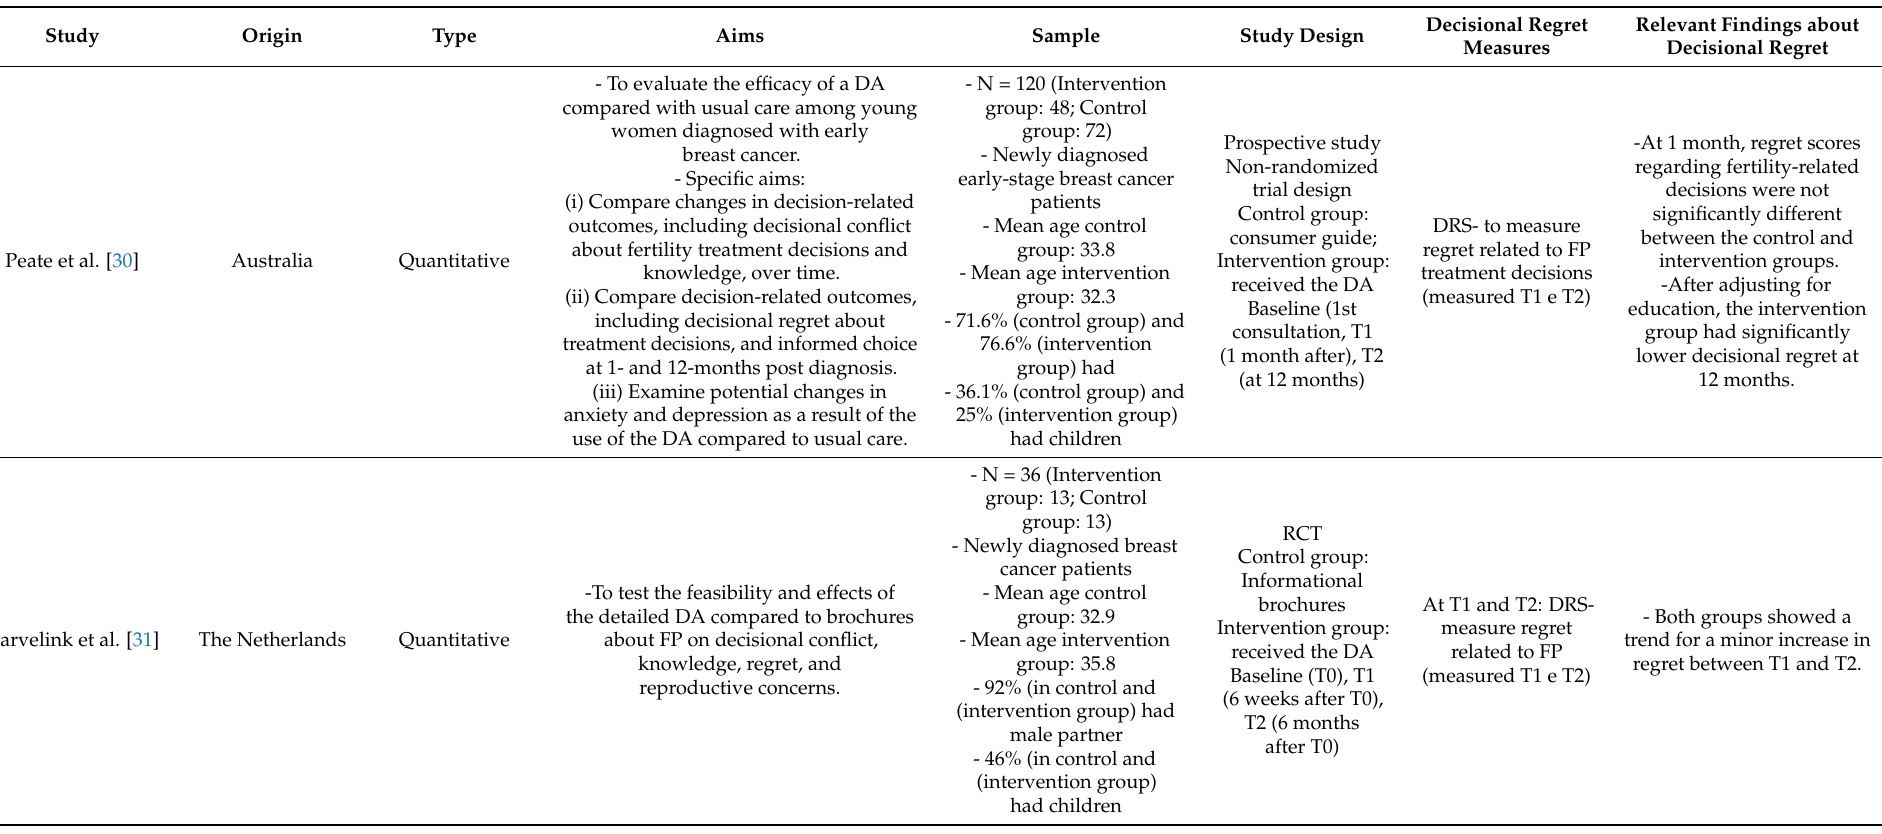
Table 2. Studies addressing decisional regret in context of decision aids